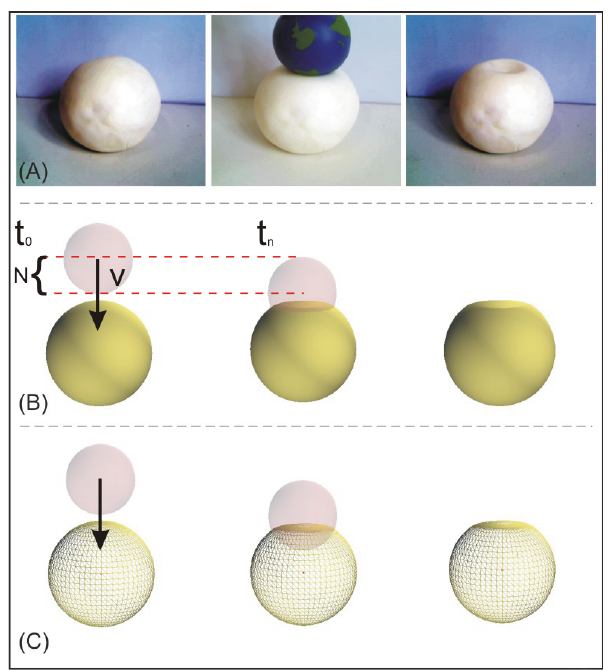
Figure 7. (A) Deformation of a modeling mass sphere by a solid sphere. (B) Deformation simulation using the proposed system. (C) In wireframe it can be seen that the deformation does not follow the shape of the sphere, generating smooth adjustments.